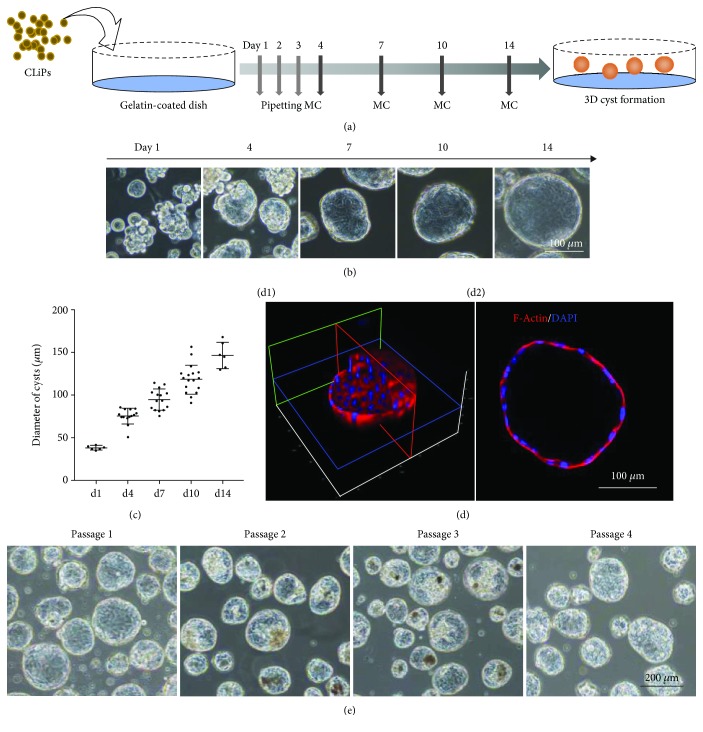
Reprogramed CLiPs form 3D cysts on gelatin-coated dishes (see also ). (a) Standardized protocol for inducing the formation of three-dimensional (3D) cysts from cultured CLiPs on gelatin-coated dishes; CLiPs were pipetted three times on each of the first three days, and culture medium change were replaced on days 4, 7, and 10. (b) Phase contrast images at indicated time points showing enlargement of 3D cysts; scale bar = 100 μm. (c) Changes in cyst diameters at indicted time points; data are shown as the means ± standard deviations (s.d.; n ≥ 6), and more than 30 cysts were chosen for each experiment at all time points. (d) Immunostaining images of F-actin microfilaments in 3D cyst structures (d1) with hollow lumens (d2); scale bar = 100 μm. (e) Phase contrast images of 3D cysts derived from CLiPs at various passages; scale bar = 200 μm.